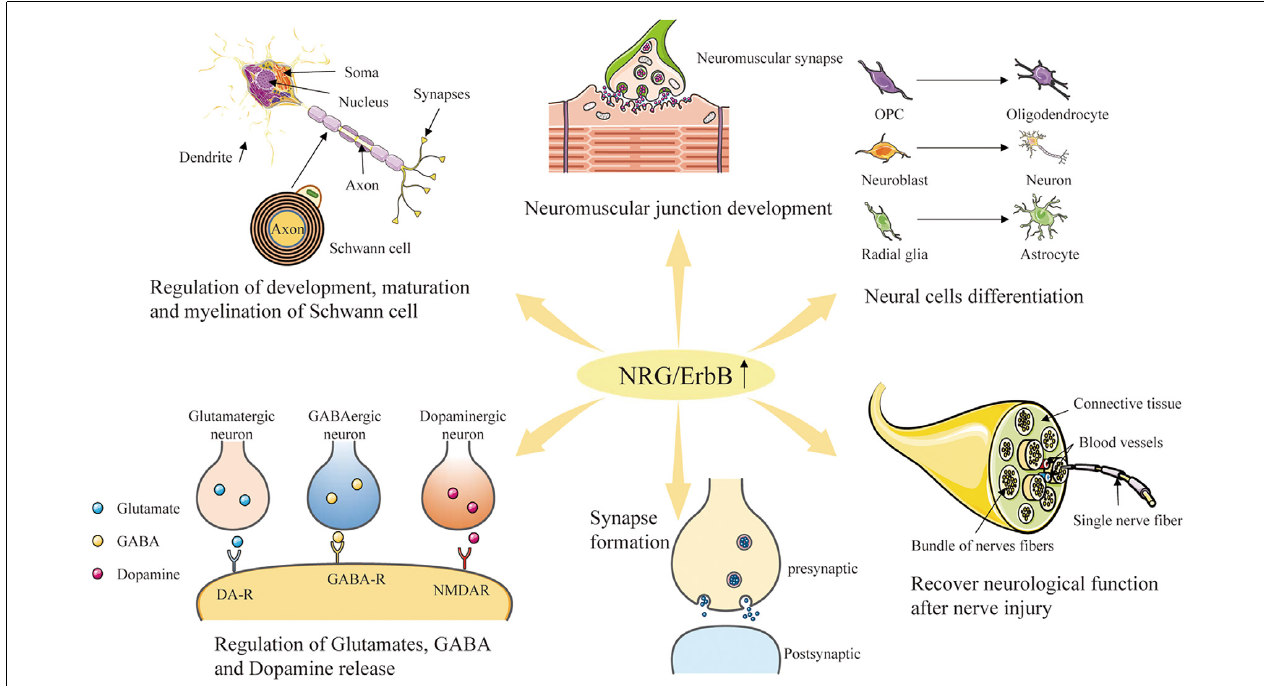
FIGURE 4 | Diverse roles of NRG/ErbB signaling in the nervous system. Through the interaction with the ErbB-family receptors to increase phosphorylation on tyrosine residues, NRG family member proteins can induce the growth, proliferation and differentiation of epithelial, neuronal and glial cells, and potentially other types of cells. Furthermore, NRGs are involved in neuromuscular junction development, repair after nerve injury, synapse formation, and regulation of glutamate, GABA and dopamine